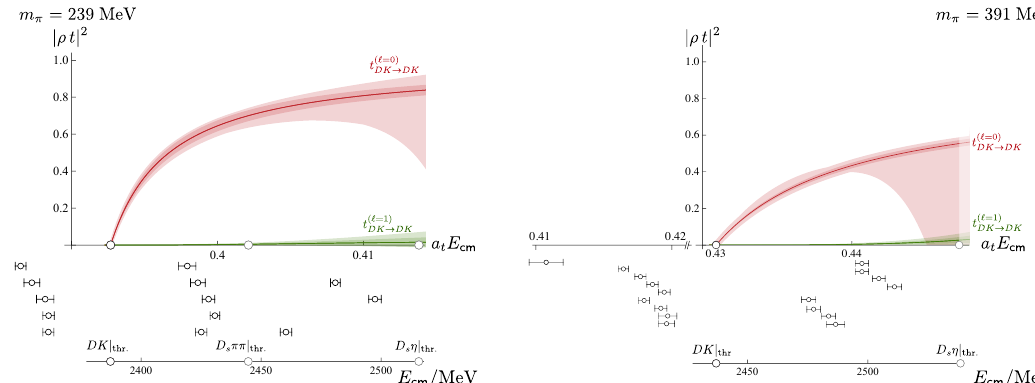
Figure 10 . As in the upper plots in figure 9, but the lighter outer bands now also include an envelope over the acceptable parameterisations in table 4 including their statistical uncertainties. The black points at the bottom show the computed finite-volume energy levels from section 4 used to constrain the